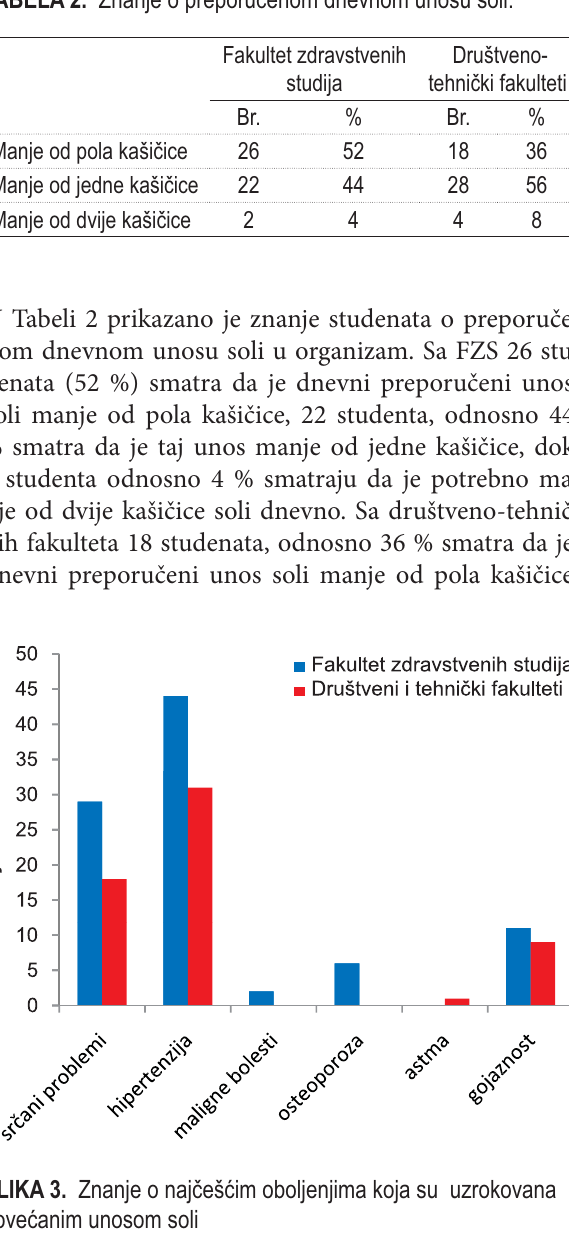
TABELA 2. Znanje o preporuwenom dnevnom unosu